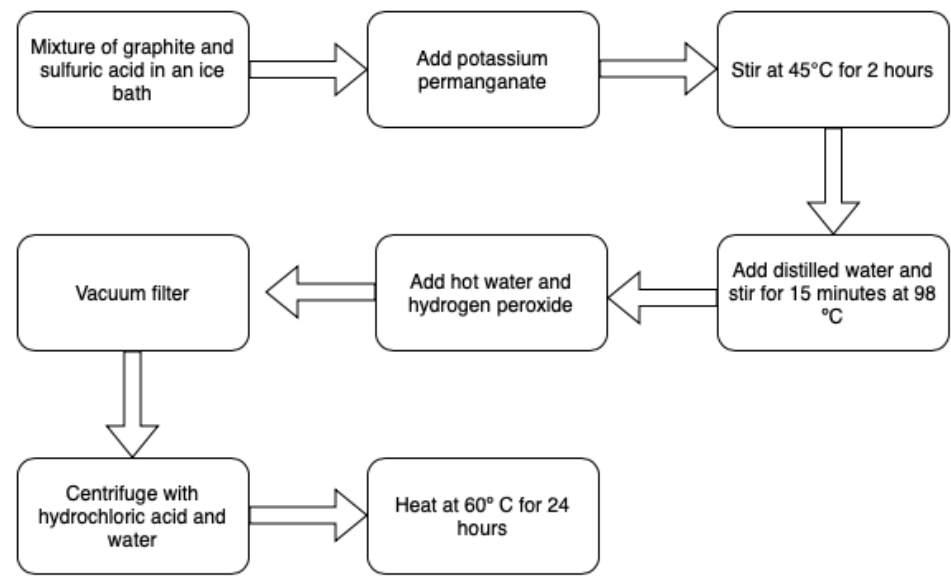
Figure 2. GO synthesis by the Hummers method at 60 °C and 90 °C for 24 h.